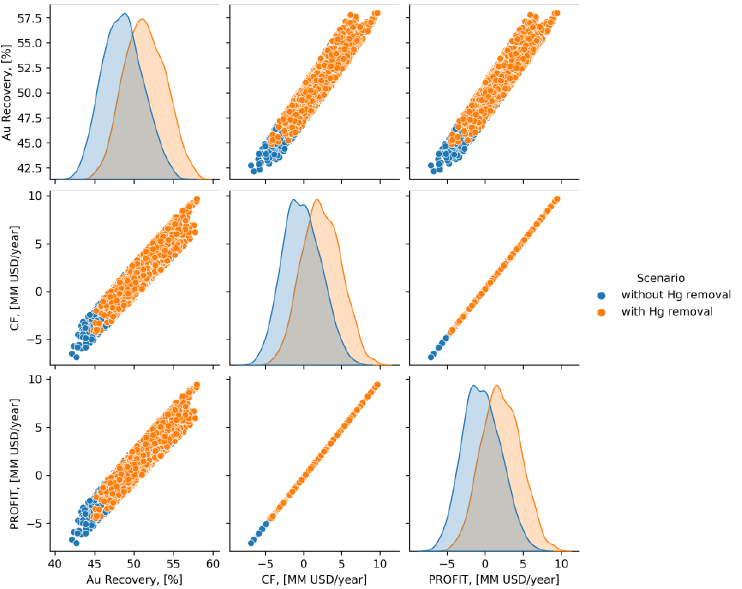
Figure 8. Pairwise bivariate distribution of the outputs for the systems using sodium thiosulfate as leaching agent. The blue results correspond to the samples that do not include Hg removal, and the orange results correspond to the samples that include Hg removal.